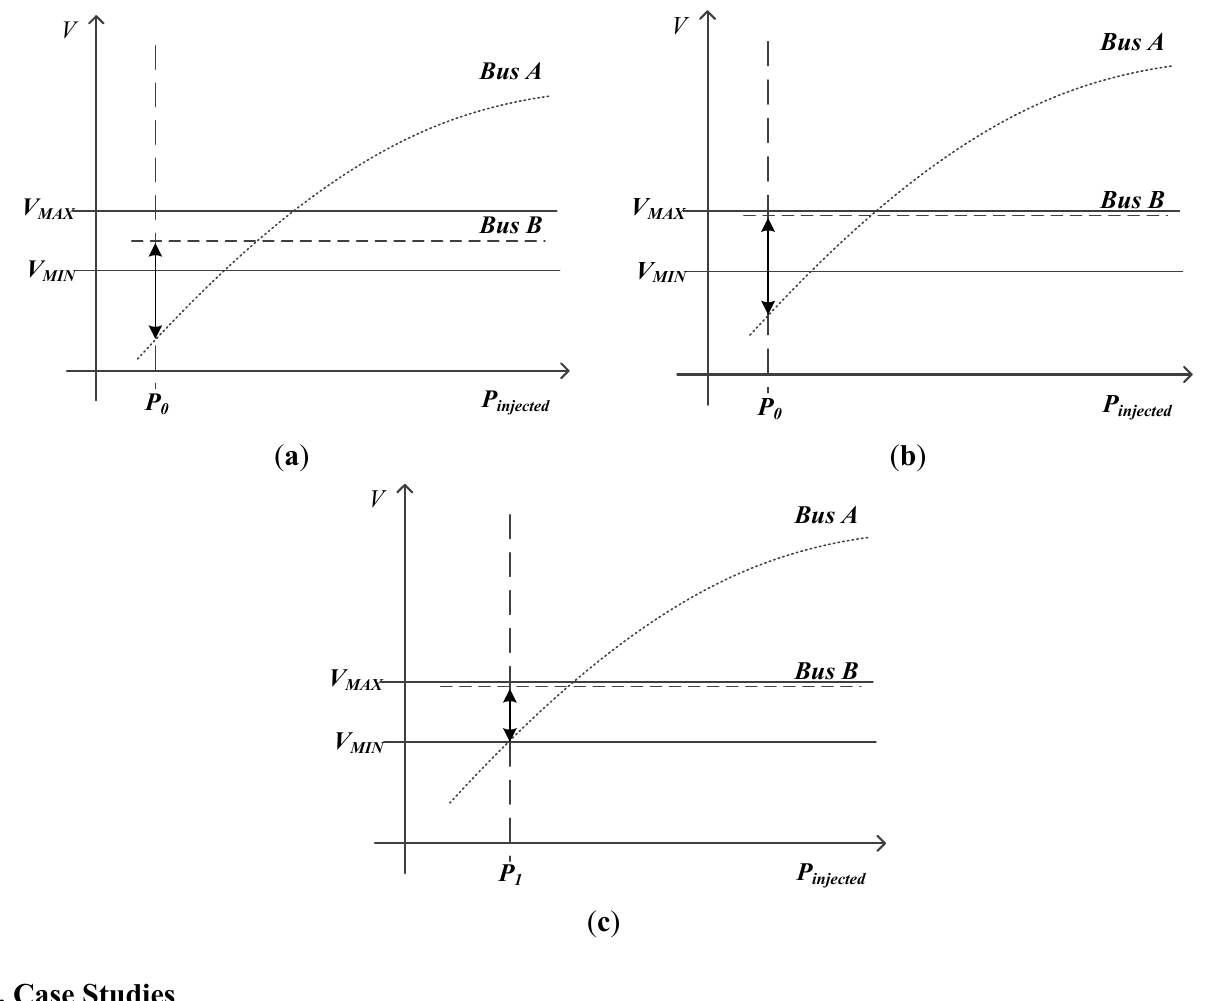
Figure 3. ( a ) Initial voltage profile; ( b ) Output voltage of the grid connected converter (GCC) is increased; ( c ) Output power of the DG is increased from P 0 to P 1 .